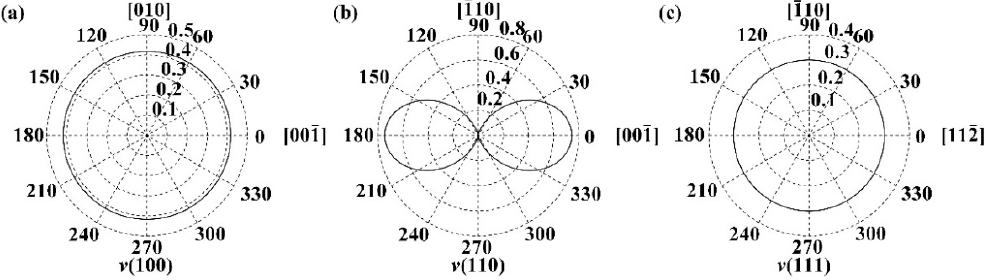
Figure 7. Direction dependence of Poisson’s ratio on low-index planes of AuCu 3 : ( a ) (100), ( b ) (110), and ( c ) (111).